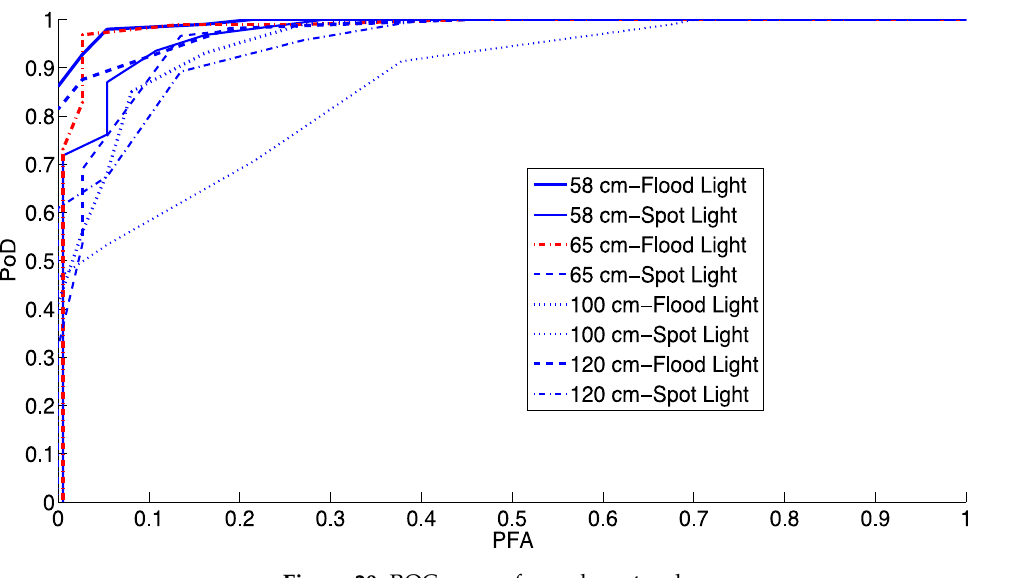
Figure 20. ROC curves for each protocol.